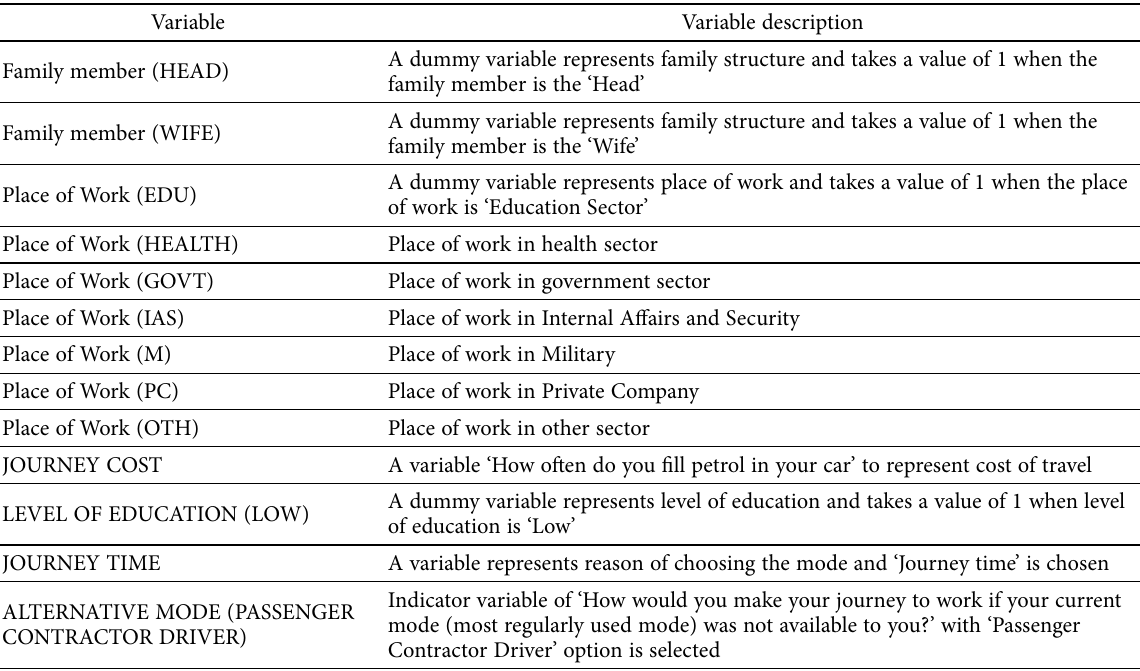
Table 4. Description of variables selected for modelling